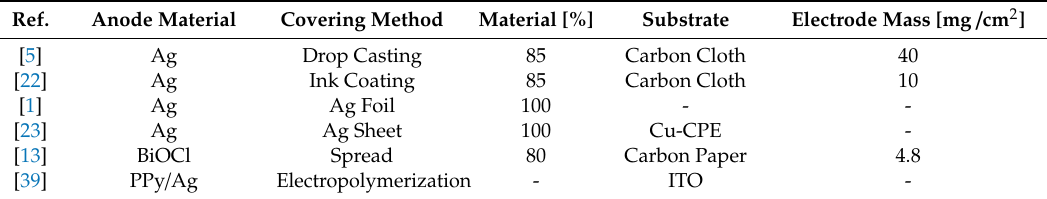
Table 6. Anode material used in